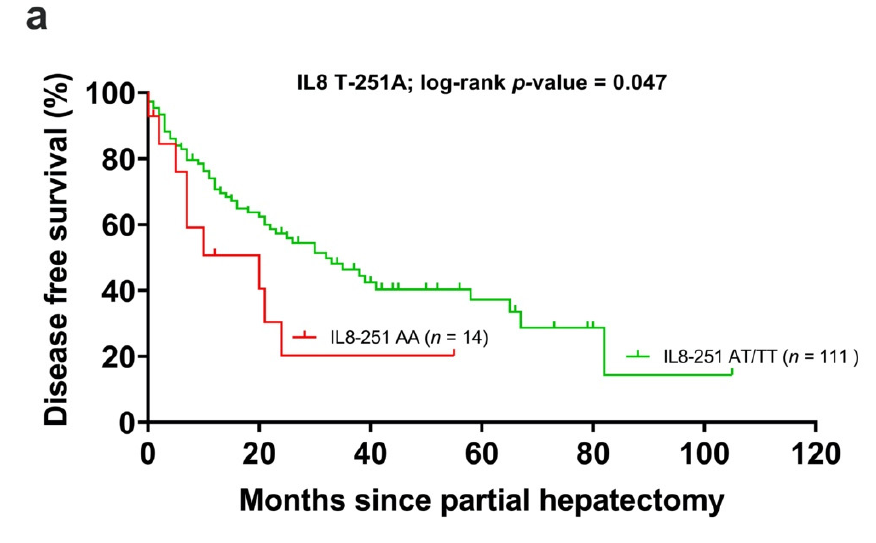
Figure 1. ( a ) Disease-free survival in the carriers of the interleukin-8 T-251A polymorphism, ( b ) the vascular endothelial growth factor C + 936T (VEGF) polymorphism and ( c ) the unfavorable alleles grouped together. Censored cases indicate the time of last follow-up for those patients who had neither recurred nor died at the time of the analysis of